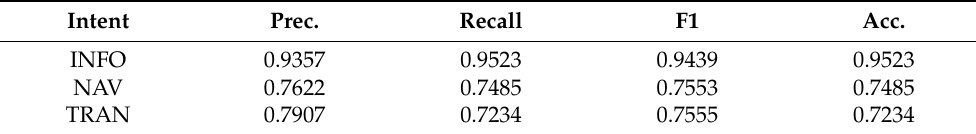
Table 8. Intent detection results with respect to the web query’s intent.